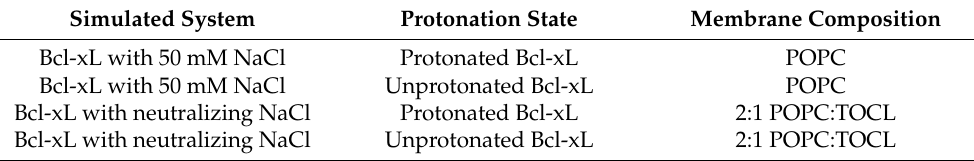
Table 1. Summary of microsecond-timescale simulations run on